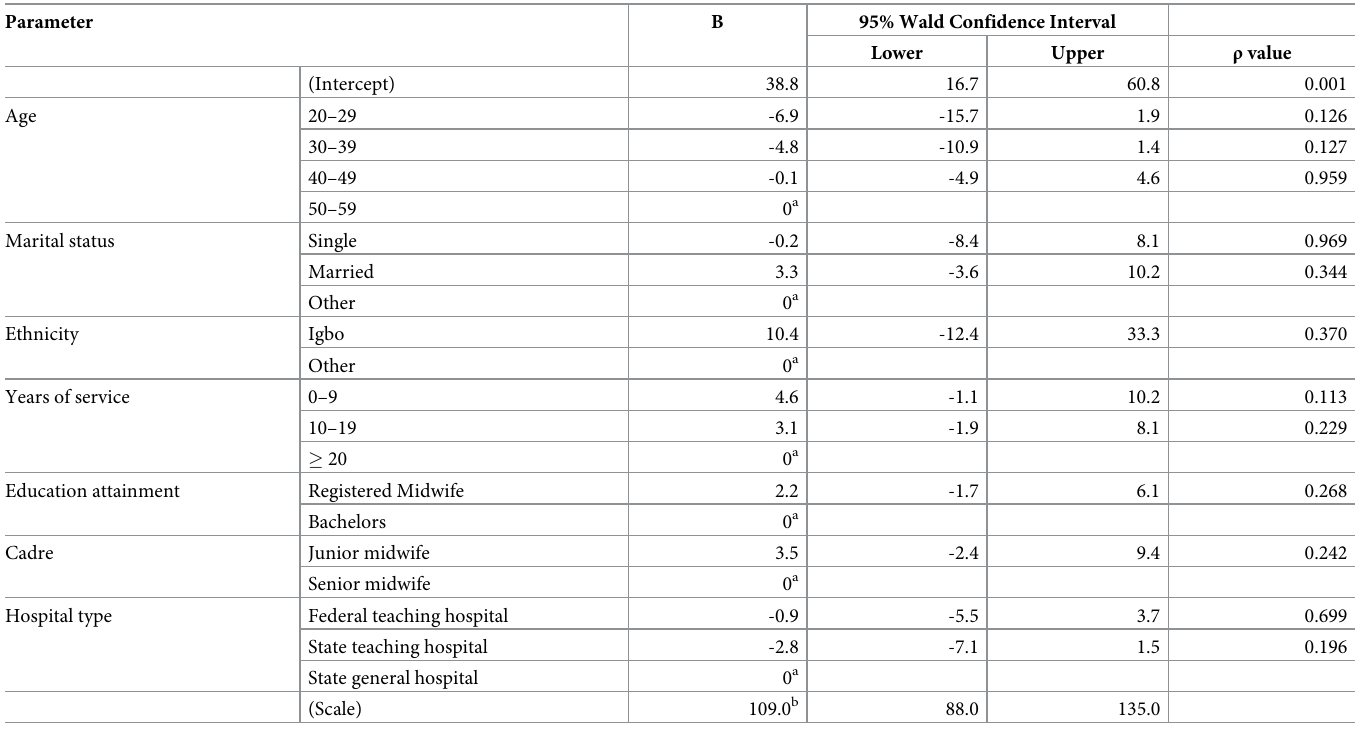
Table 7. Predictors of midwives’ perception of person-centred maternity